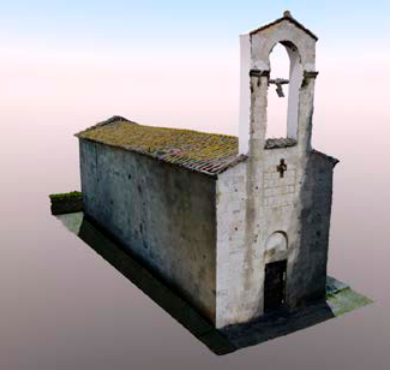
Figure 5. Laser scanner - UAV SfM integrated model